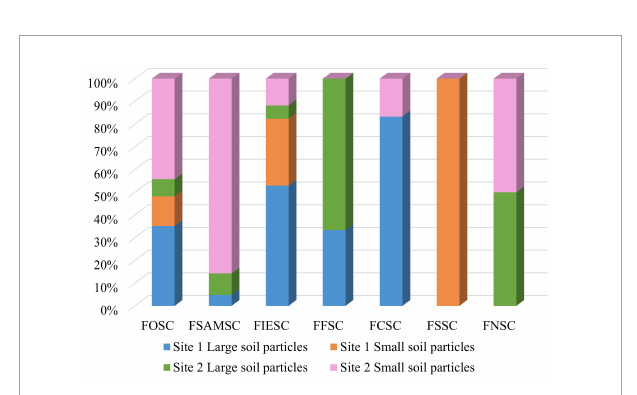
FIGURE4 The number of isolates obtained per species complex between the two sampling sites from the respective soil particle sizes.